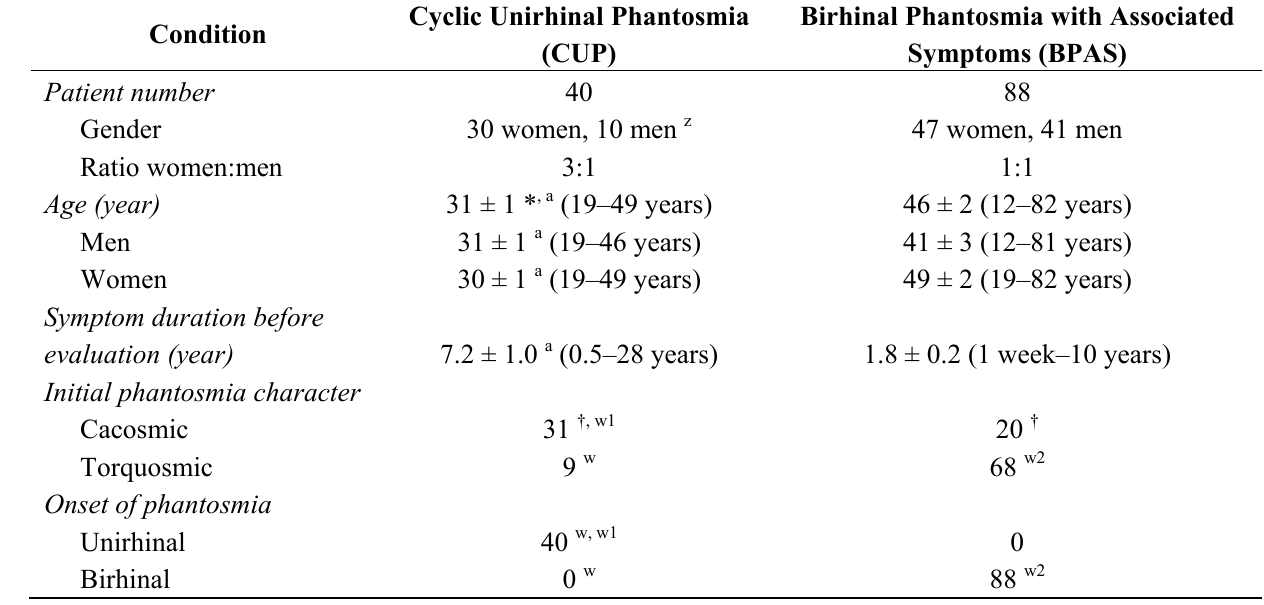
Table 1. Clinical characteristics of patients with